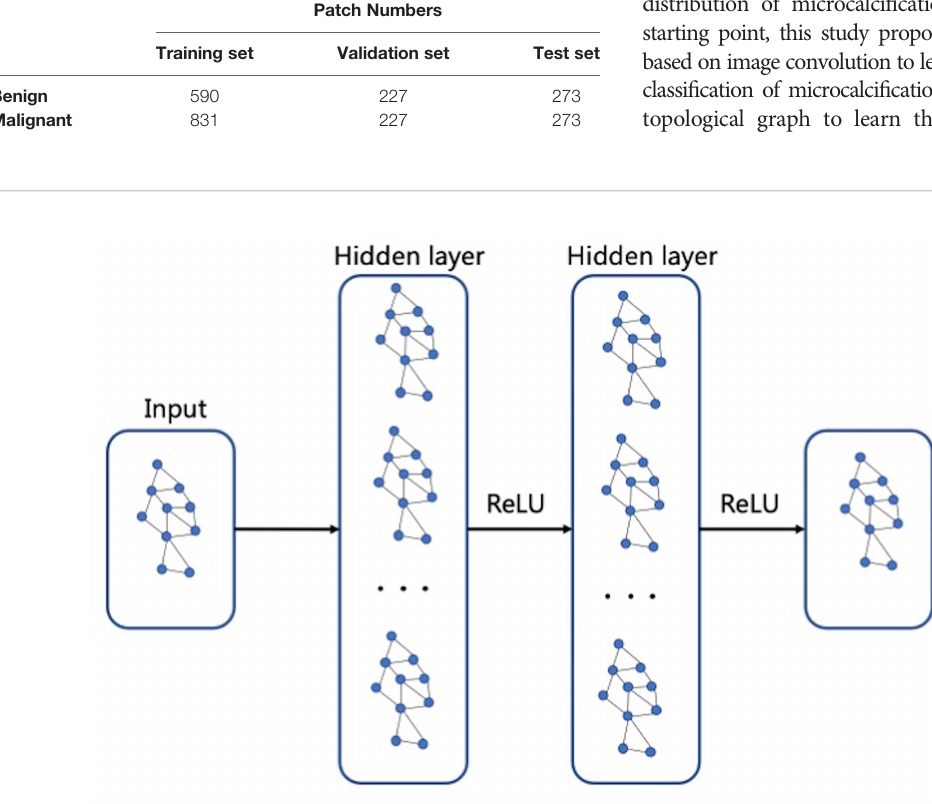
FIGURE 7 | Graph neural